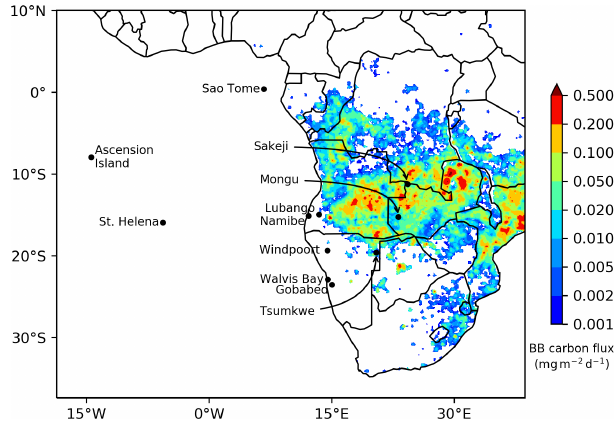
Figure 1. Meso-NH domain. The color shading shows the GFED emission of biomass burning carbon averaged between 1 and 16 September